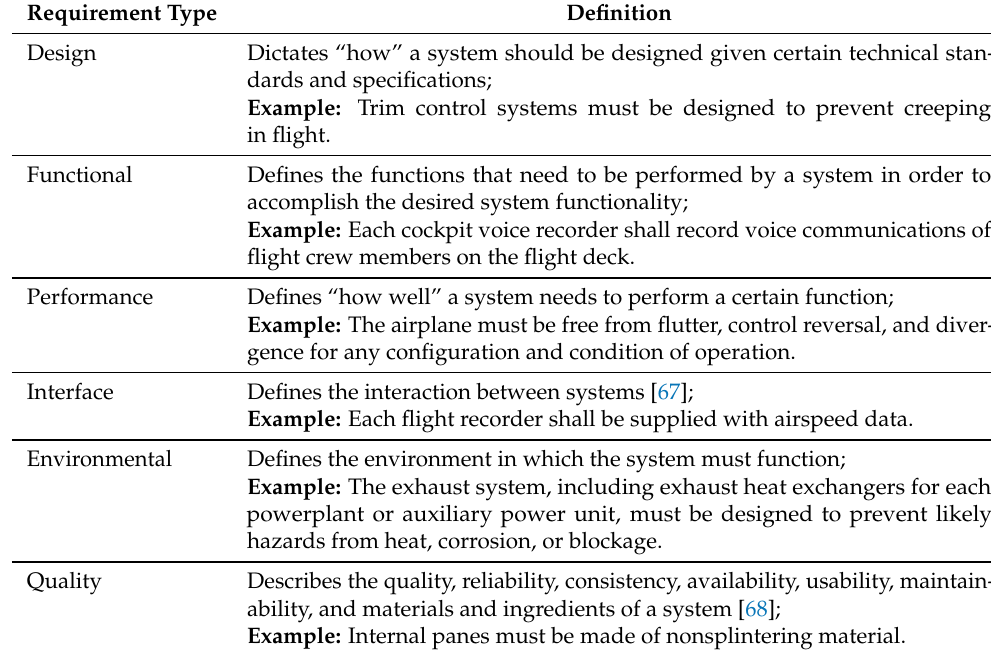
Table 5. Definitions used for labeling/annotating requirements